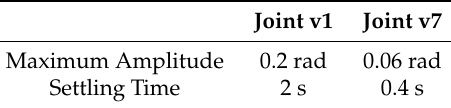
Figure 9. Comparison of both joints of a disturbance response. Table 4. Comparison between